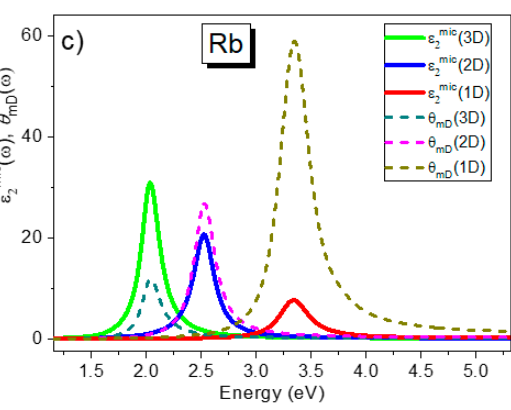
Figure 1. Calculated spectra ε mic 2 (𝜔) for 1D, 2D and 3D confinement for ( a ) Na, ( b ) Cs and ( c ) Rb. In Figure 1b, the result of calculations using Equation (11) is shown by the dashed curve 3, while dashed curve 2 corresponds to the calculated Im[1 / ( ε ( ω ) + 1)] function and the dashed curve 1 to the Im[1/ ε ( ω )] function. Note that the dashed curves are normalized using different factors for convenience of presentation. In ( c ), the dotted lines correspond to the frequency dependent local field factor θ mD ( ω ), calculated using Equation (9) at m = 1, 2 and 3.